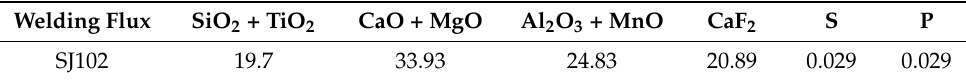
Table 2. The main composition of the SJ102 welding flux (mass fraction%).